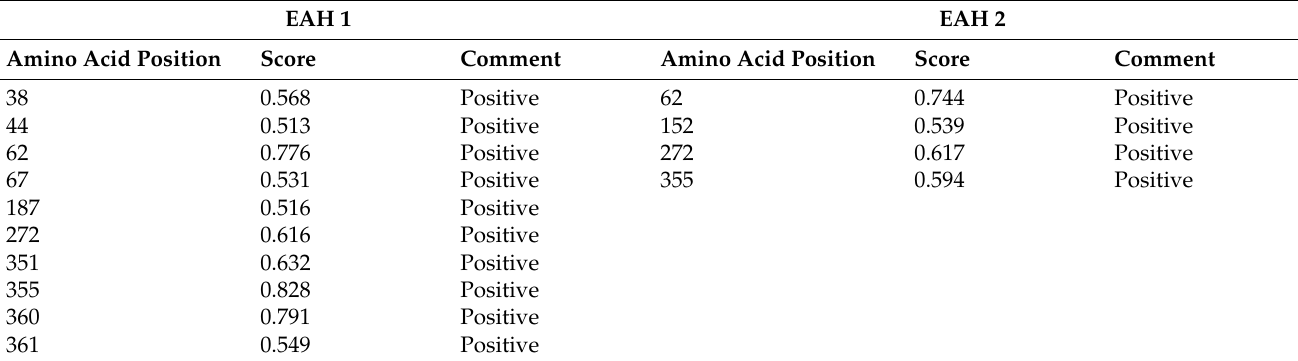
Figure 5. Predicted binding sites of N-glycans on the identified proteins secreted by A. niger GH1. ( A ) represents the graphic for EAH 1 and ( B ) are the results obtained for EAH 2. Table 4. O-glycans binding sites prediction.